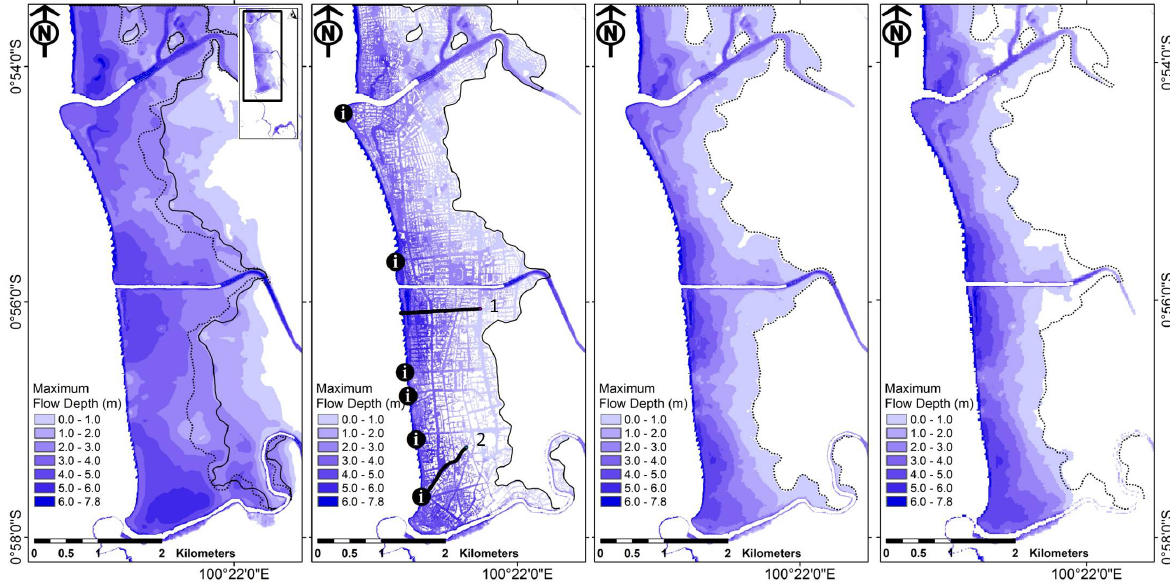
Fig. 13. Comparison of the maximum flow depth. From left to the right hand side: CRM, TM, ERM (5m), and ERM (15m). Cross-sections and control points on TM are used for elevation check in Figs. 14 and 15. Dashed line in CRM and in the ERM (15m) indicate the maximum inundation line of the ERM, while the solid line in CRM is the maximum inundation line from the